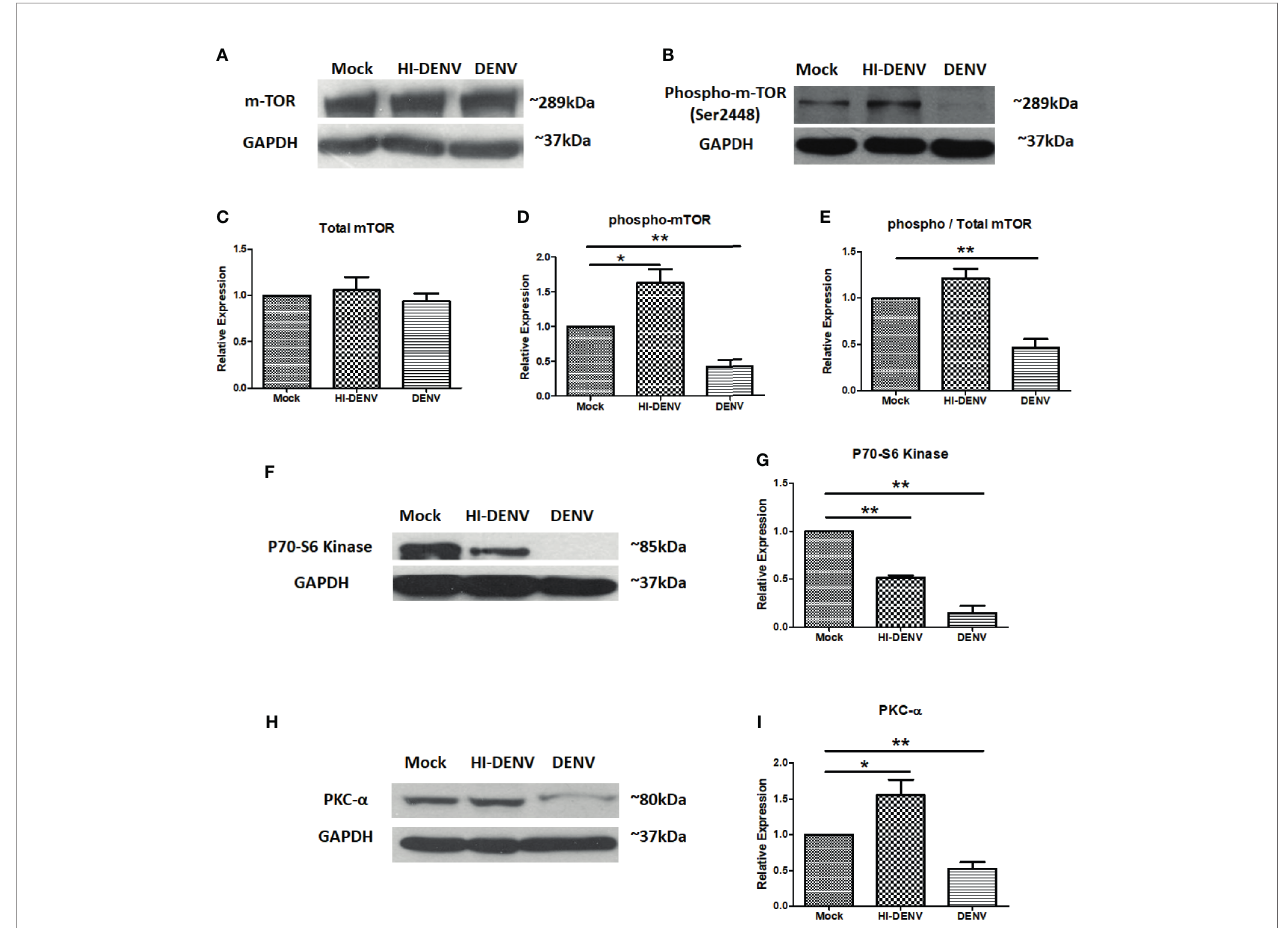
FIGURE 3 | Immunoblotting of mTOR and associated proteins. (A, B) Representative immunoblots of total mTOR and phospho-mTOR (Ser2448) in mock, DENV inactivated virus treated, and DENV infected MEG-01 cell lysate. Graphical representation of the expression of mTOR (C) total mTOR, (D) phospho-mTOR, and (E) ratio of phospho and total mTOR expression. Representative immunoblots and relative expression of (F, G) P70-S6 kinase and (H, I) PKC- a in mock-infected, DENV inactivated virus treated, and DENV infected MEG-01 cell lysate. (*pValue < 0.05; **pValue <